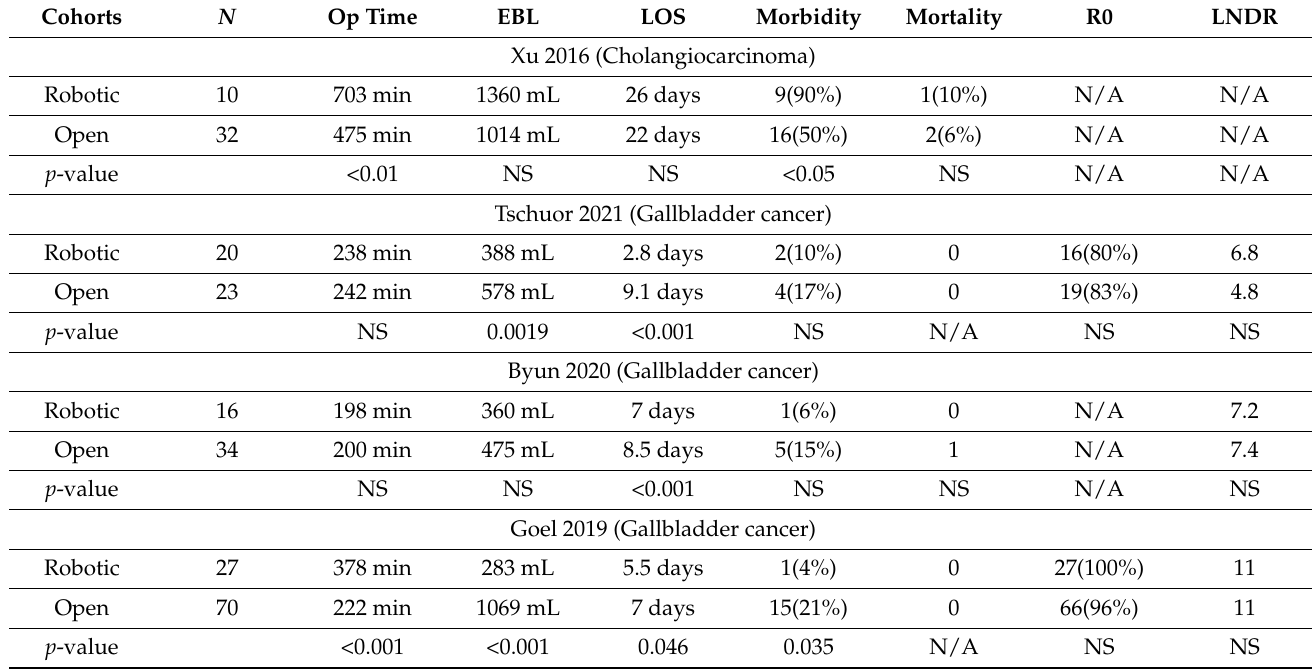
Table 2. Summary of studies that performed comparative